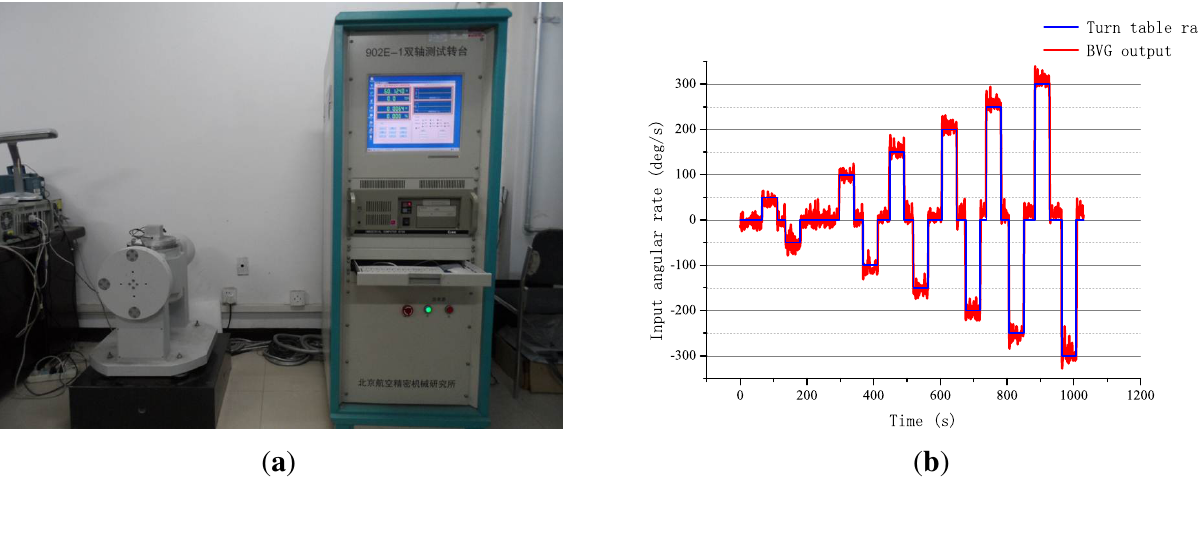
Figure 16. The turntable